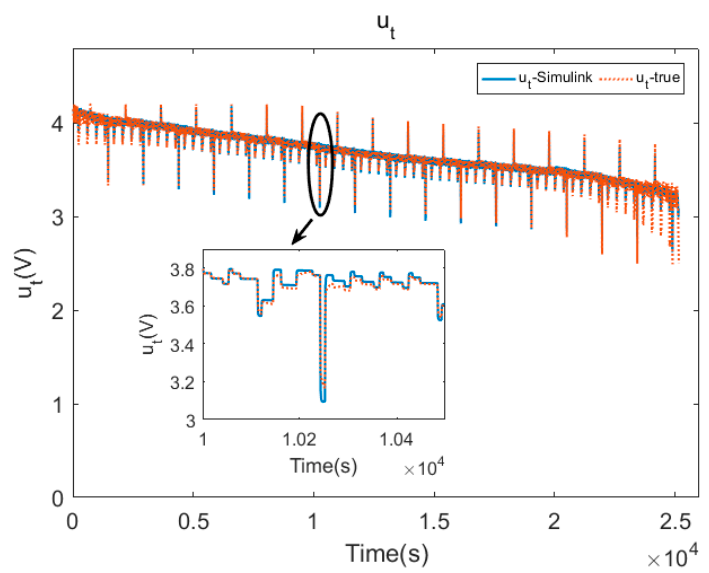
Figure 6. Comparison between simulated voltage and true voltage.